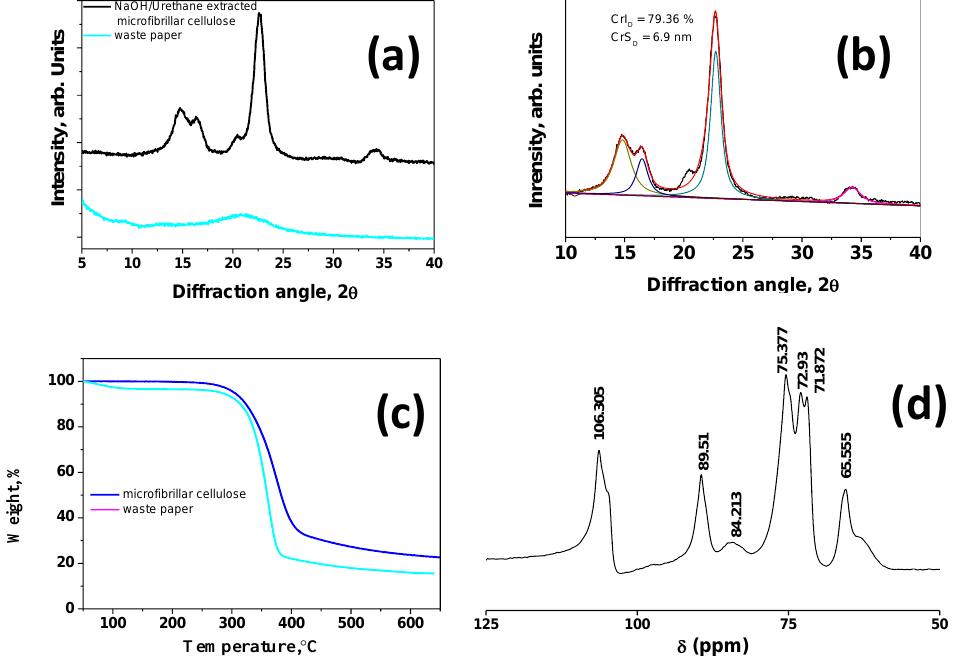
Figure 3. X-ray diffraction (XRD) and thermogravimetric analysis (TGA) of waste paper and microfibrillar cellulose ( a , c ), deconvoluted XRD spectra ( b ), and solid state 13C cross-polarization magic angle spinning nuclear magnetic resonance (CP-MAS NMR) spectrum of microfibrillar cellulose ( d ).